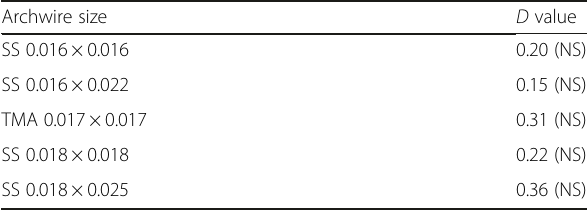
Table 2 D value of the non-parametric Kolgomorov-Smirnov test for each type of lingual archwires and their statistical significance ( p <